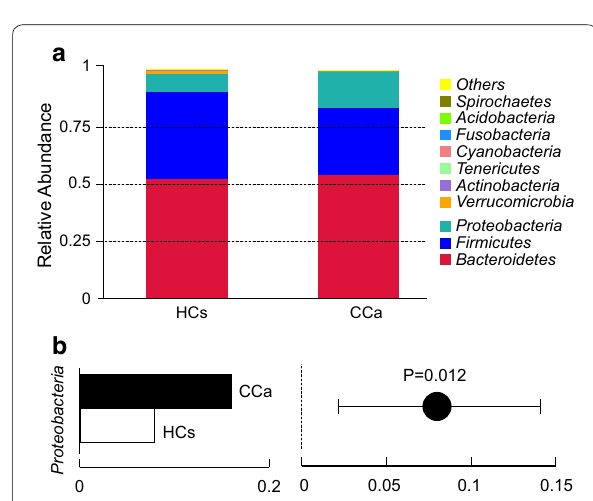
Fig. 3 Composition of gut microbiota in patient with cervical cancer on the phylum level. a The relative abundance of bacteria in the stool sample from the two groups. b The relative abundance of Proteobacteria was significantly higher in patients compared with controls (P =